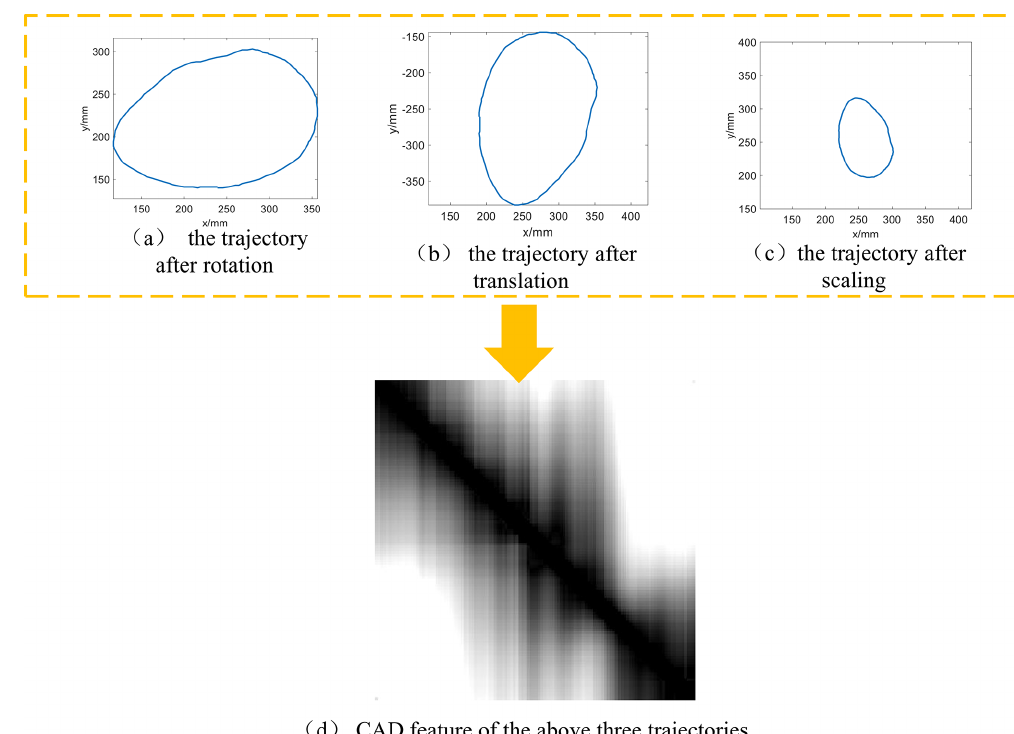
Figure 3. Three trajectories differ by similarity transformation and their CAD images.